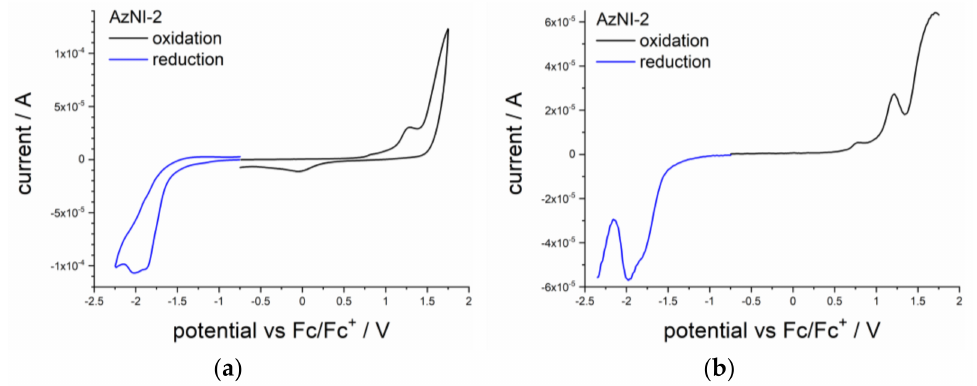
Figure 2. ( a ) Cyclic voltammetry (CV) and ( b ) differential pulse voltammetry (DPV) scans of AzNI-2 (scan rate 0.10 V/s, electrolyte 0.1 M Bu 4 NPF 6 in dichloromethane). Table 2. Electrochemical investigation results of the investigated N -hexyl-1,8-naphthalimides derivatives. E red a E red(onset) a Molecule Method